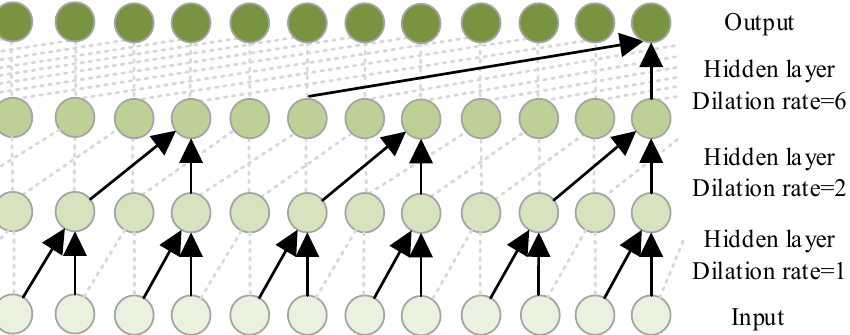
Figure 1. Schematic diagram of dilated convolution with dilation rates of 1, 2, and 6, respectively.